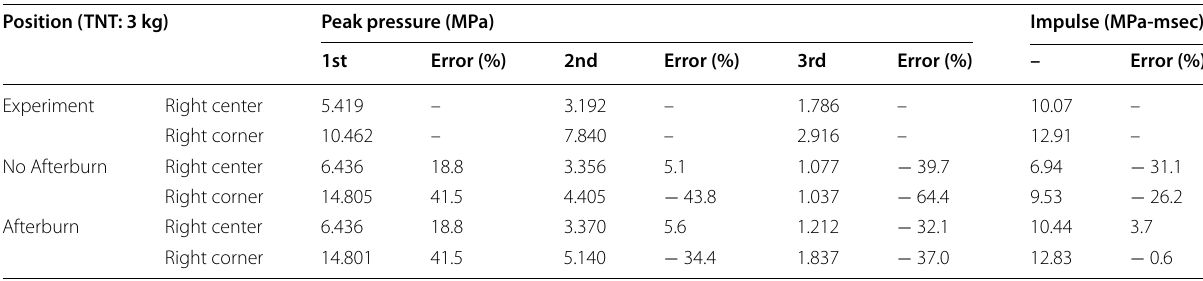
Table 5 Comparison of peak pressure and